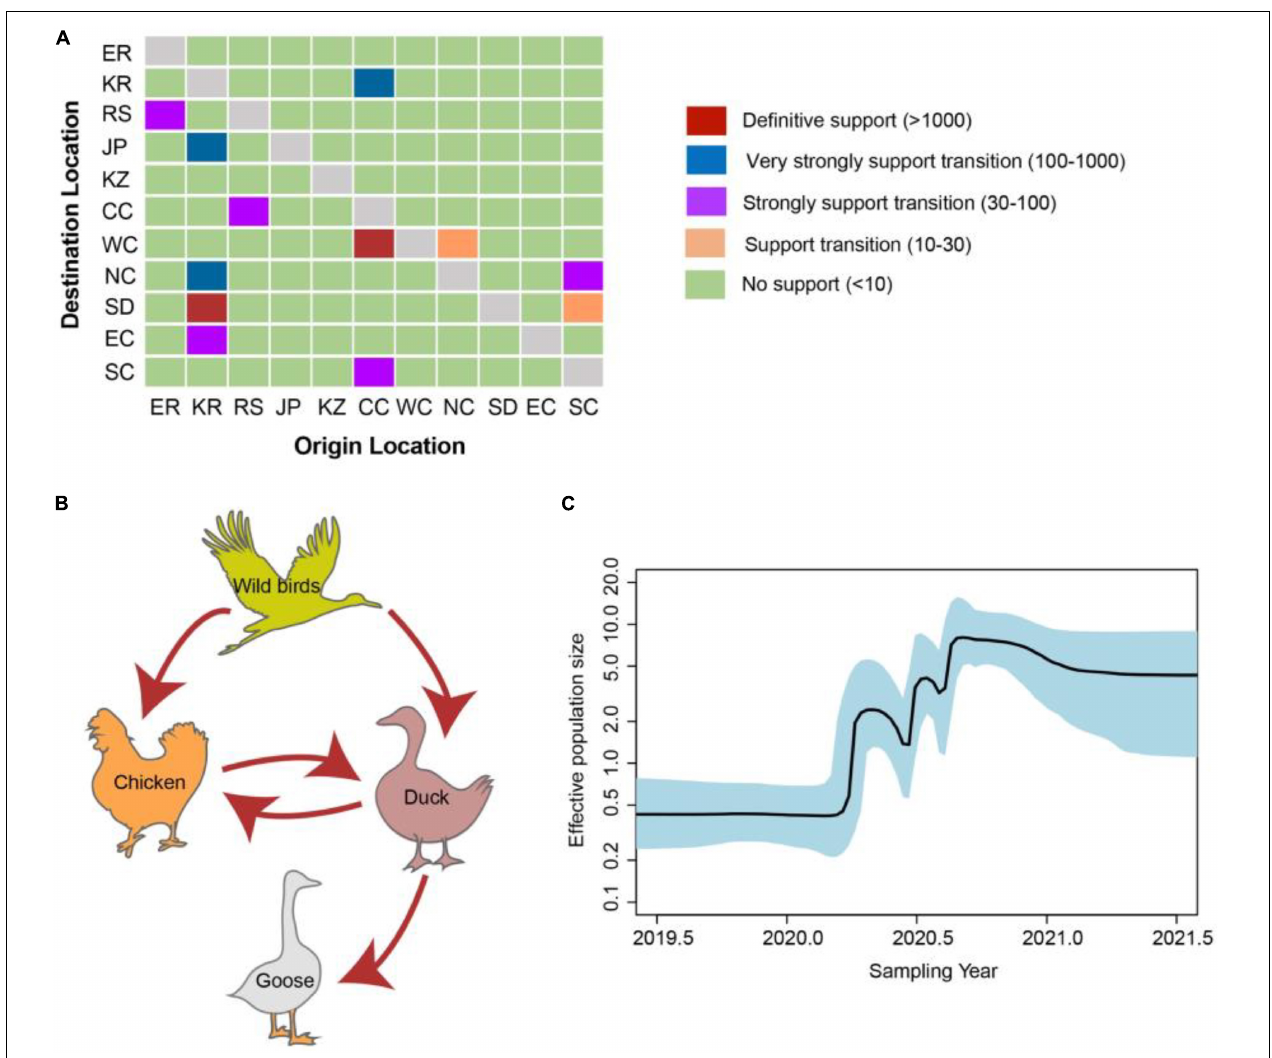
FIGURE 5 | Evolutionary dynamics of clade 2.3.4.4b H5 subtype influenza viruses during 2020–2021 and level of Bayes factor (BF) support for each transmission routes. (A) The transmission of clade 2.3.4.4b H5 subtype influenza viruses during 2020–2021. The left and right panels display the level of Bayes Factor support for each of the transmission routes considered for H5 subtype viruses. The x-axis represents the origin location, and the y-axis represents the destination. ER, Europe; KR, Korea; RS, Russia; JP, Japan; KZ, Kazakhstan; CC, Central China; WC, Western China; NC, Northern China; SD, Shandong province of China; EC, Eastern China; SC, Southern & Southwestern China. (B) Host transition of clade 2.3.4.4b H5 subtype influenza viruses during 2020–2021. Analyzing transition routes with BF values exceeding 3 were selected for analysis. The red arrowheads represent BF exceeding 100. (C) Bayesian Skyline plot of HA gene of clade 2.3.4.4b H5 subtype influenza viruses during 2020–2021. A Bayesian Skyline analysis of HA gene of clade 2.3.4.4b H5 subtype influenza viruses during 2020–2021 to display changes in the effective population size over time. The solid blue line indicates the median value, and the shaded blue area represents the 95% highest posterior density of genetic diversity estimates. The Bayesian Skyline plot was estimated using R package (version